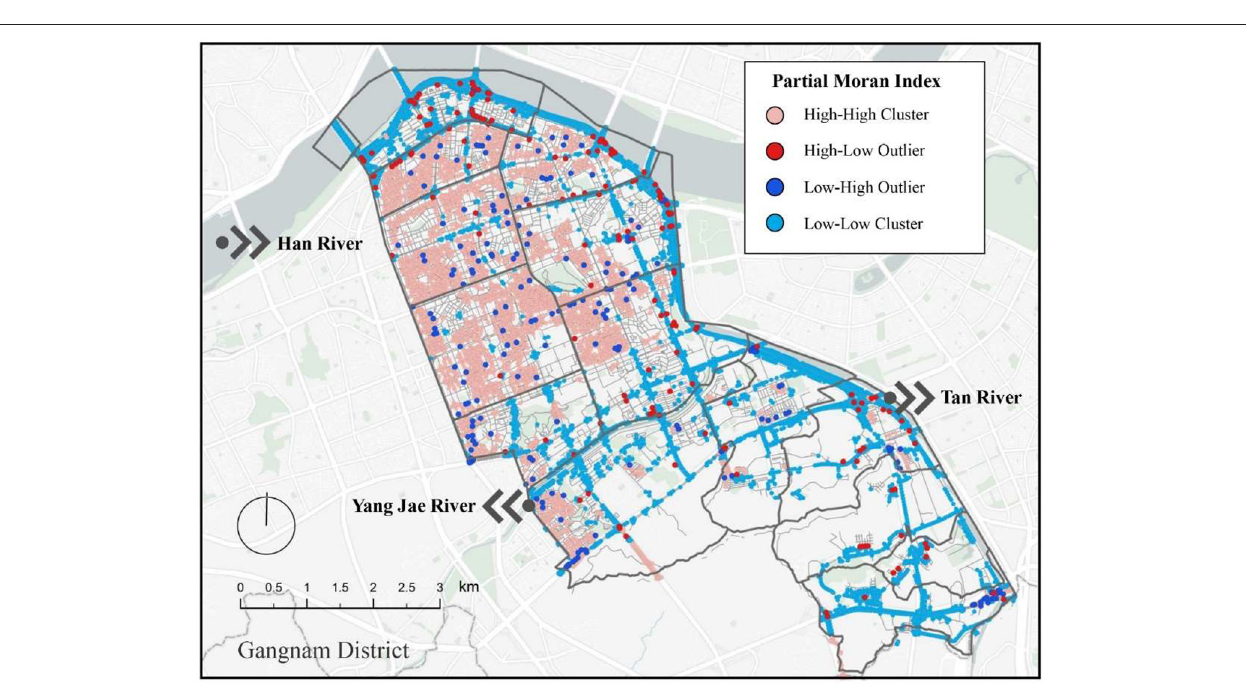
FIGURE 11 | Spatially localized autocorrelation distribution map for